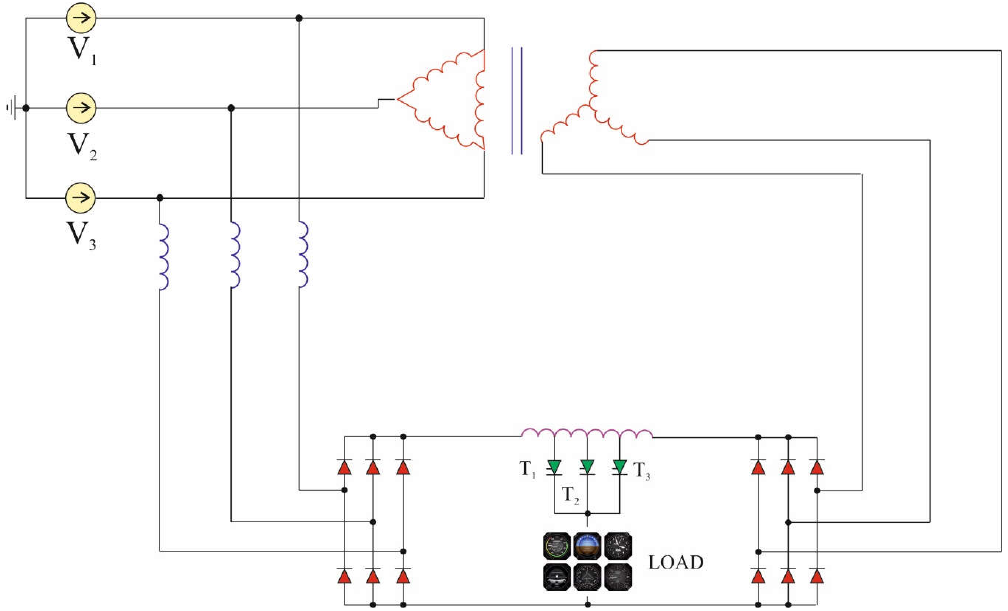
Figure 3. Diagram of a classic 36-pulse rectifier powered by a three-phase transformer.